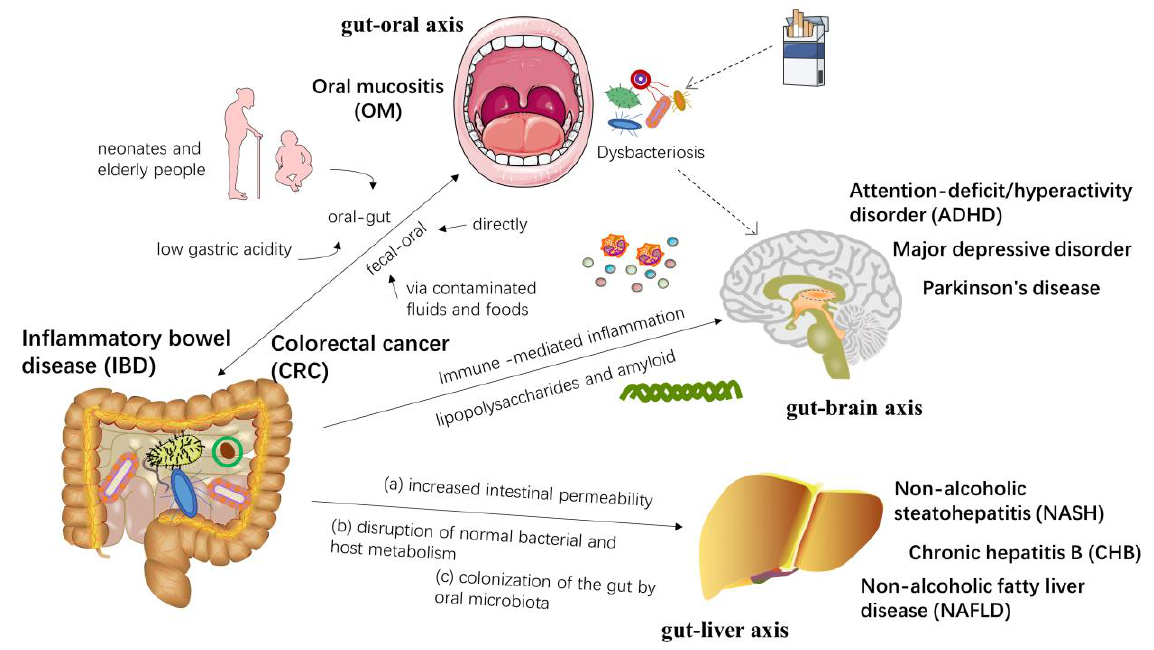
Figure 3. Several common “gut-organ axis” diseases and their